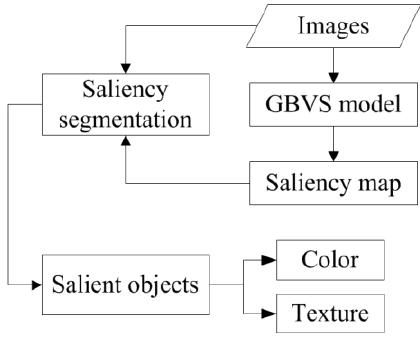
Figure1. Architecture of proposed method